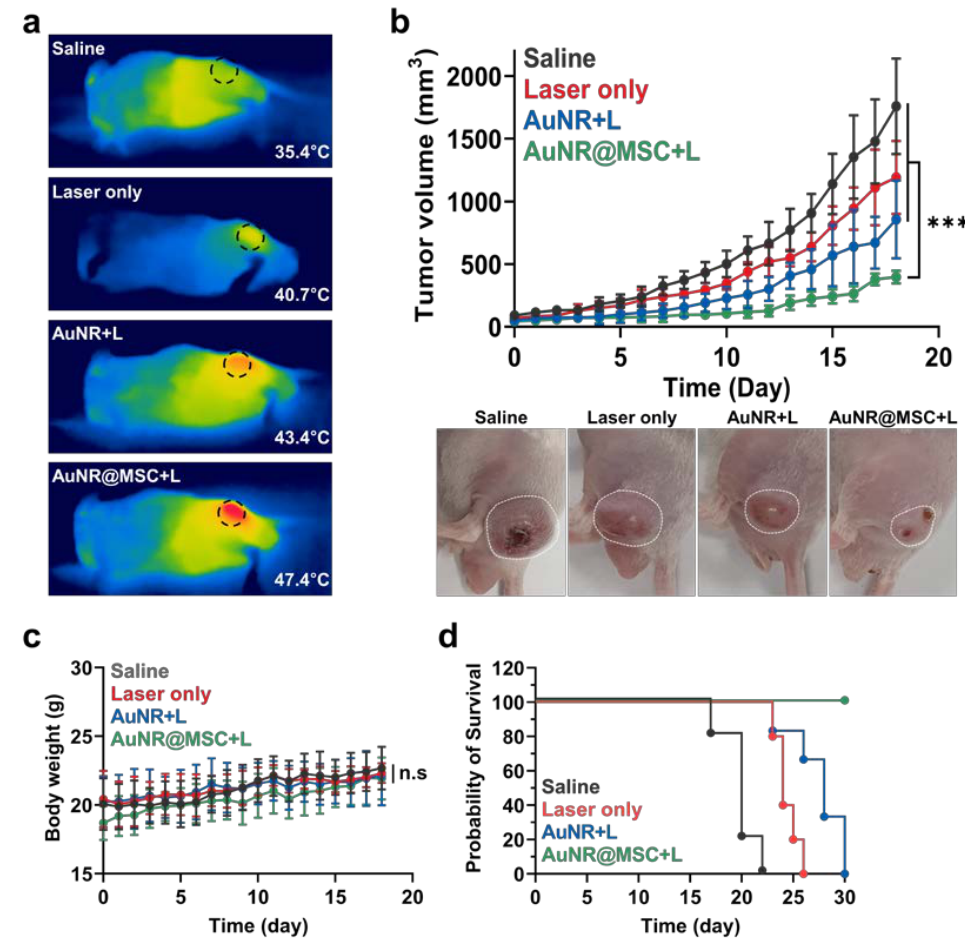
Figure 5. Therapeutic efficacy of PTT by AuNR@MSCs in colon tumor models. ( a ) Photothermal images of HT29 tumor-bearing mice after treatment with saline, Laser only, AuNR+L, or AuNR@MSC+L. ( b ) Tumor growth of HT29 tumor-bearing mice after treatment with saline, Laser only, AuNR+L, or AuNR@MSC+L. ( c ) Body weight changes during treatment. ( d ) Survival of mice after treatment with saline, Laser only, AuNR+L, or AuNR@MSC+L. Statistical significance is indicated with asterisks (*** p < 0.001)